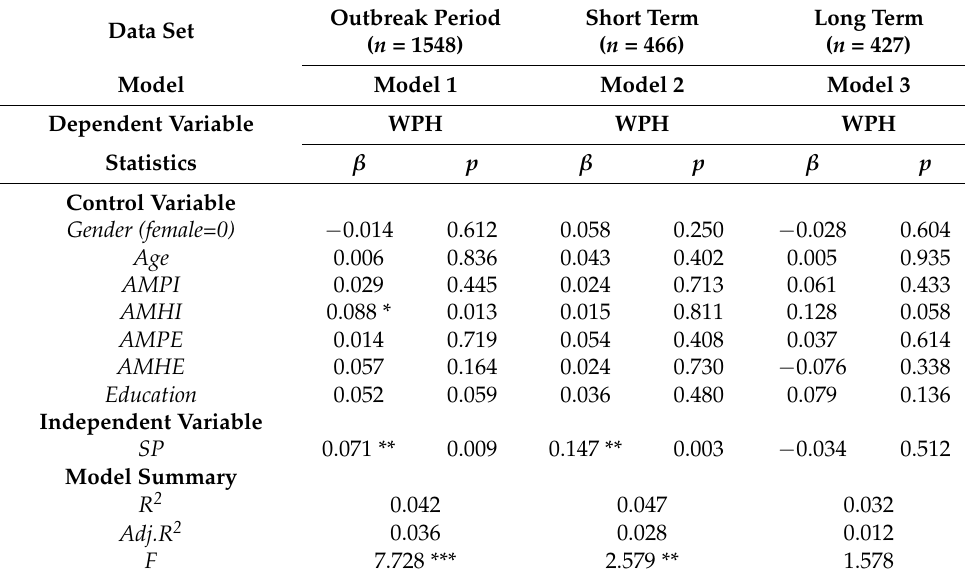
Table 2. Main effects of SP on WPH.